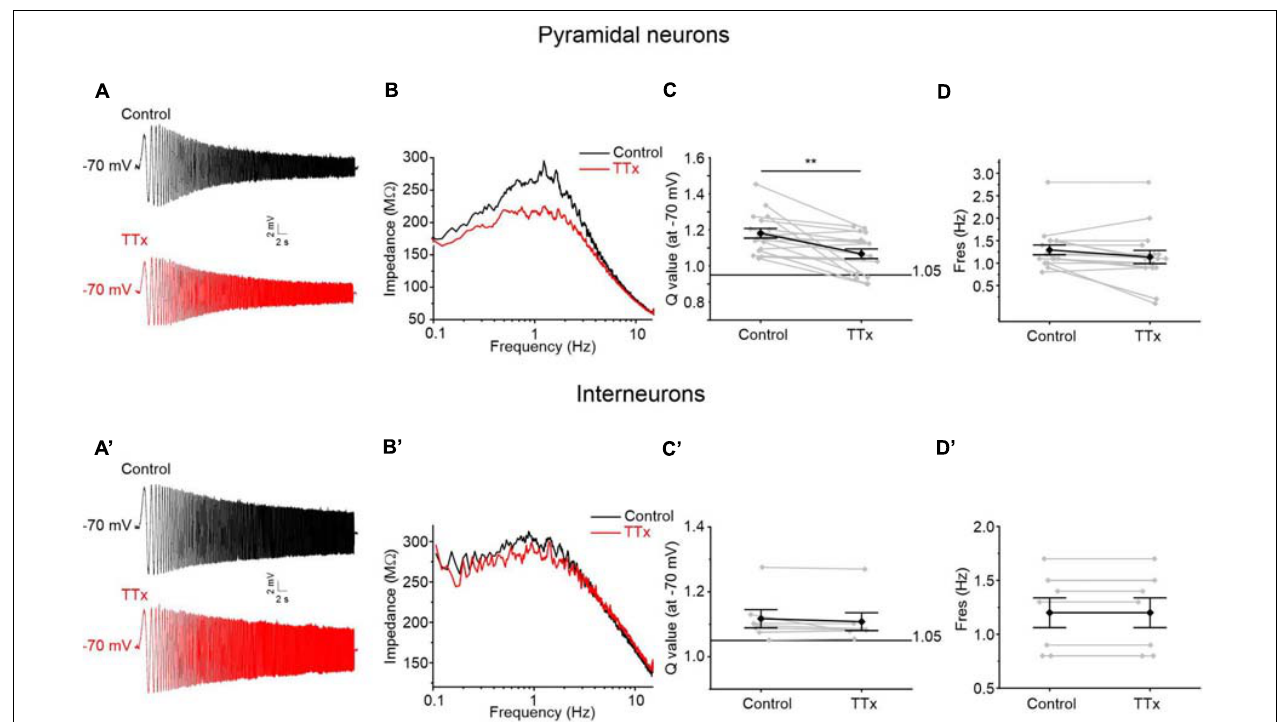
FIGURE 9 | Effects of the block of TTx-sensitive sodium channels on resonant behavior of pyramidal neurons (A–D) and GABAergic interneurons (A (cid:48) –D (cid:48) ) of the PRC. (A) Voltage responses of a representative resonant pyramidal neuron to the standard 0–15 Hz ZAP protocol at –70 mV before (upper trace in black) and after (lower trace in red) the perfusion of TTx 1 µ M. (B) Impedance-to-frequency relationship of the same cell as in (B) , before (black line) and after (red line) TTx perfusion. (C,D) Scatter plots comparing the Q -values (C) and F res values (D) derived from resonant pyramidal neurons ( N = 17) before (Control) and after (TTx) blocking the TTx-sensitive Sodium channels (gray dots and lines). Mean ± SEM. Q -values are reported on the same plot in black. In TTx condition, the Q -value is significantly reduced and then the resonance strength is attenuated (C) . The F res is unaltered by TTx administration (D) . (A (cid:48) –D (cid:48) ) Same as (A–D) for GABAergic interneurons ( N = 7). In GABAergic interneurons TTx perfusion has no effect either on the Q -value (C (cid:48) ) or on the F res (D (cid:48) ) . Data in (C,D,C (cid:48) ,D (cid:48) ) were compared by paired Student’s t -test. ** p <